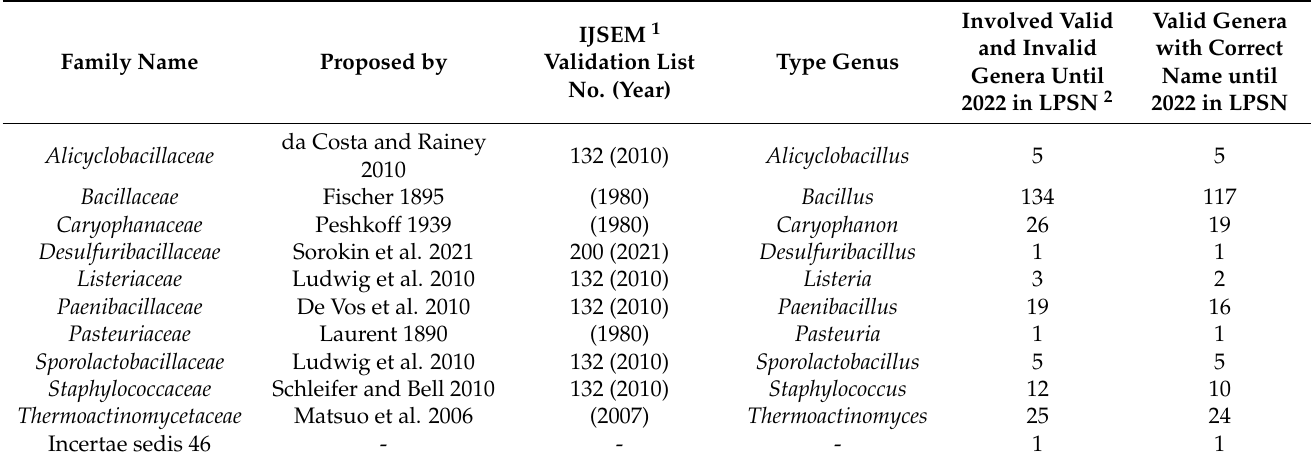
Table 1. List of families assigned to the order Bacillales